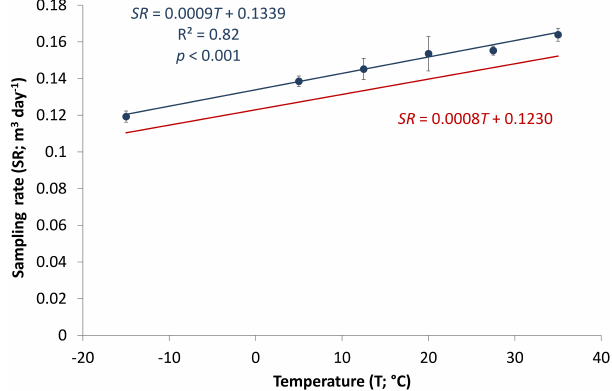
Figure 2. The effect of temperature on the sampling rate of a pas- sive air sampler for gaseous mercury as determined experimentally (blue) and as calculated using the diffusion model (red) by McLa- gan et al. (2016b). The measured and calculated temperature depen- dence, given by the slopes of the relationships, is not significantly